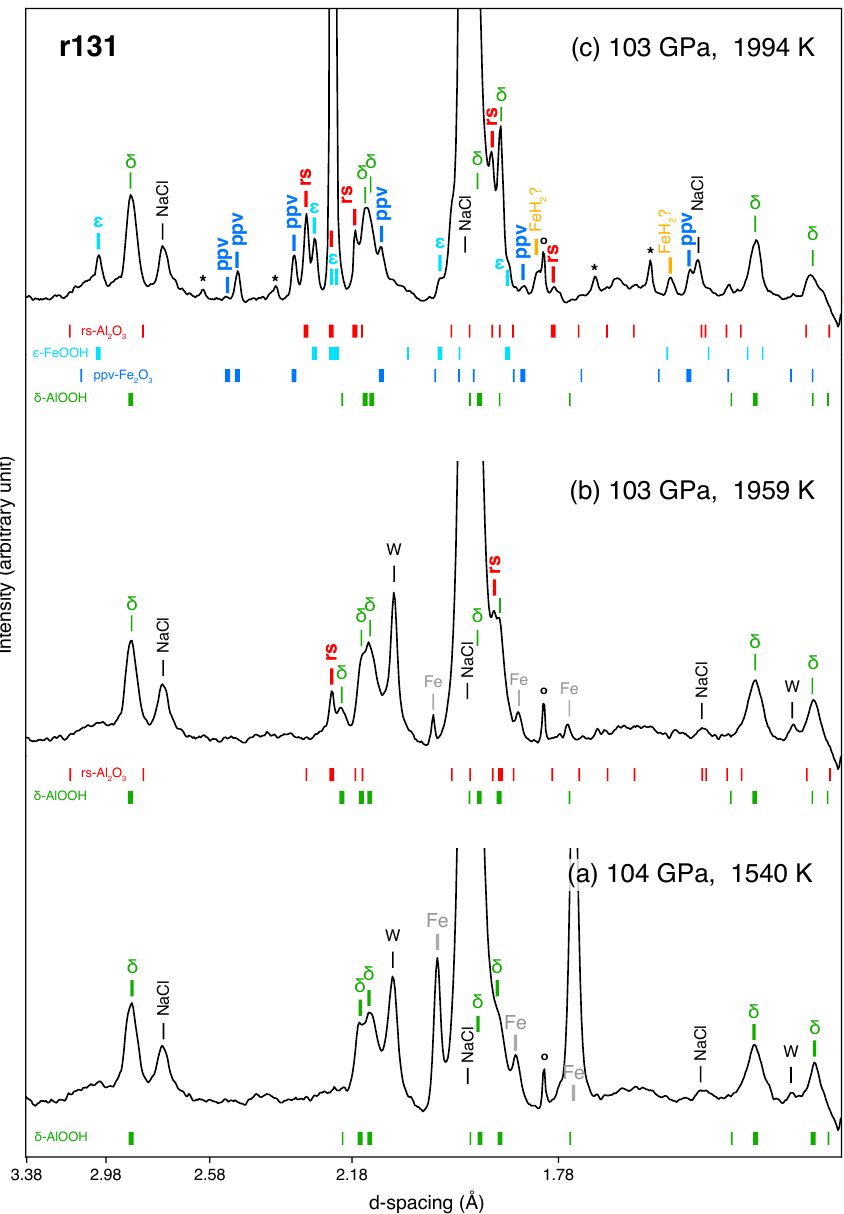
Figure 2. Dehydration of δ -AlOOH detected in XRD patterns for run#131. ( a ) At 1540 K, precursor materials (i.e., δ -AlOOH, Ar and Au) as well as W (see Text for details) are present; ( b ) at 1959 K, new peaks appear, which can be indexed as rs-Al 2 O 3 ; ( c ) at 1994 K, metallic iron contained in the starting material is found to react with released H 2 O and produce (cid:101) -FeOOH and ppv-Fe 2 O 3 . Some peaks might also be attributed to FeH 2 . The circles ( ◦ ) denote unidentified lines present before heating. The stars ( ∗ ) denote unidentified lines appearing during heating. The calculated peak positions for the phases are shown as vertical ticks with different colors. The thick ticks refer to identified peaks, while the thin ticks are calculated peak positions for which identification was less robust. X-ray energy was 30